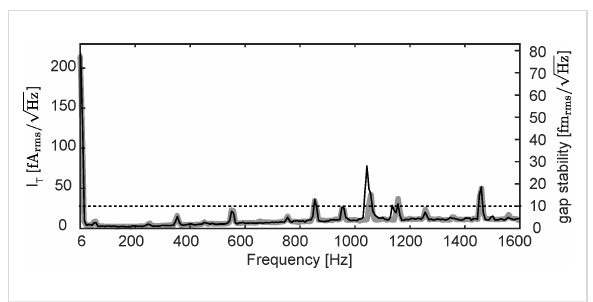
Figure 10: The current noise spectral density with the tip retracted from and approached to the surface of an electrically conducting sam- ple for measurement bandwidths of 0 to 1600 Hz. The current noise spectral density with the retracted tip is displayed as a wide gray curve with the current noise on the left vertical scale. The current noise spec- tral density with the approached tip is displayed as a solid black line with the tunneling current noise on the left vertical scale and with a converted noise of the tip–sample gap stability on the right vertical scale. The dashed horizontal black line indicates a noise level of 10 fm/ .